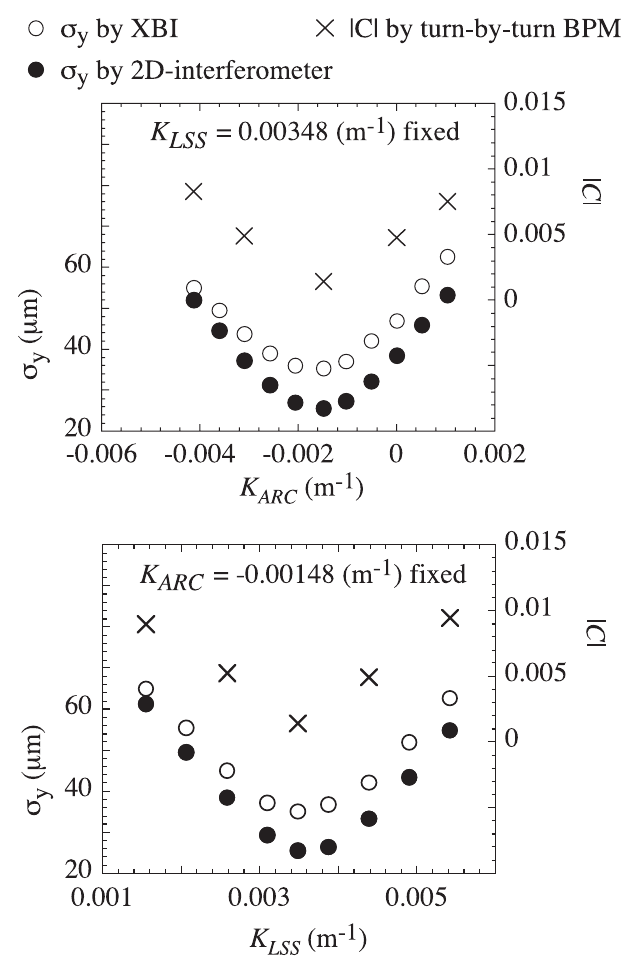
FIG. 4. Vertical beam sizes measured by the XBI (open circles) and the 2D interferometer (filled circles), and j C j (crosses) measured by the turn-by-turn BPM as a function of K ARC and K LSS . For both beam-size monitors of XBI and 2D interferome- ter, the minimum vertical beam sizes are given when ð K ARC ; K LSS Þ are ( (cid:1) 0 : 001 48 m (cid:1) 1 , 0 : 003 48 m (cid:1) 1 ), where the measured j C j also becomes minimum. The working point was chosen at ð (cid:1) x ; (cid:1) y Þ ¼ ð 40 : 3818 ; 18 : 3451 Þ , near the difference